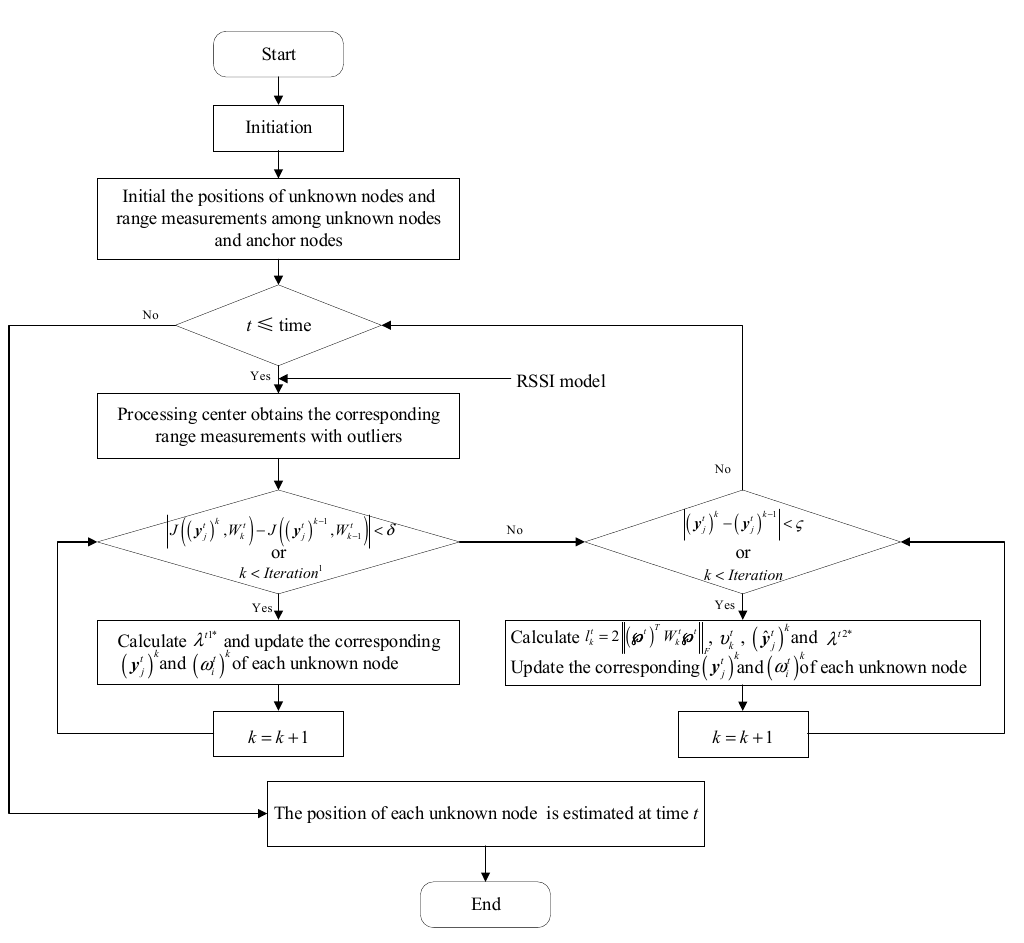
Figure 2. Flowchart of the robust, non-cooperative localization algorithm (RNLA). RSSI = received signal strength indication.